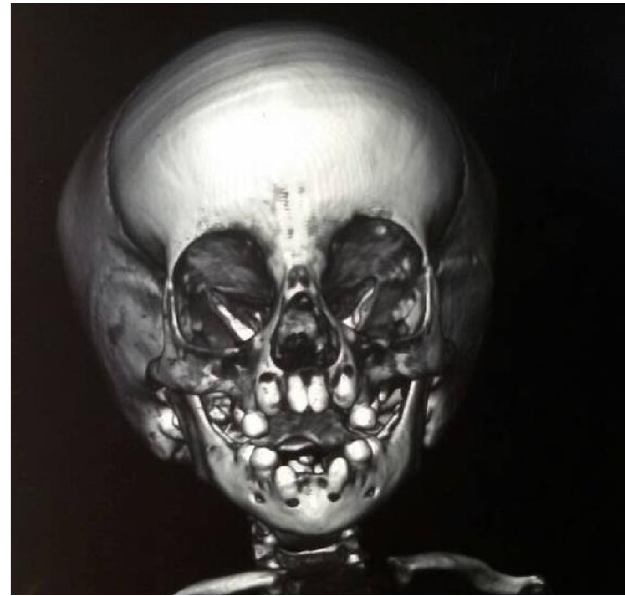
Fig. 9. X-ray facial reconstruction showing oligodontia and conical